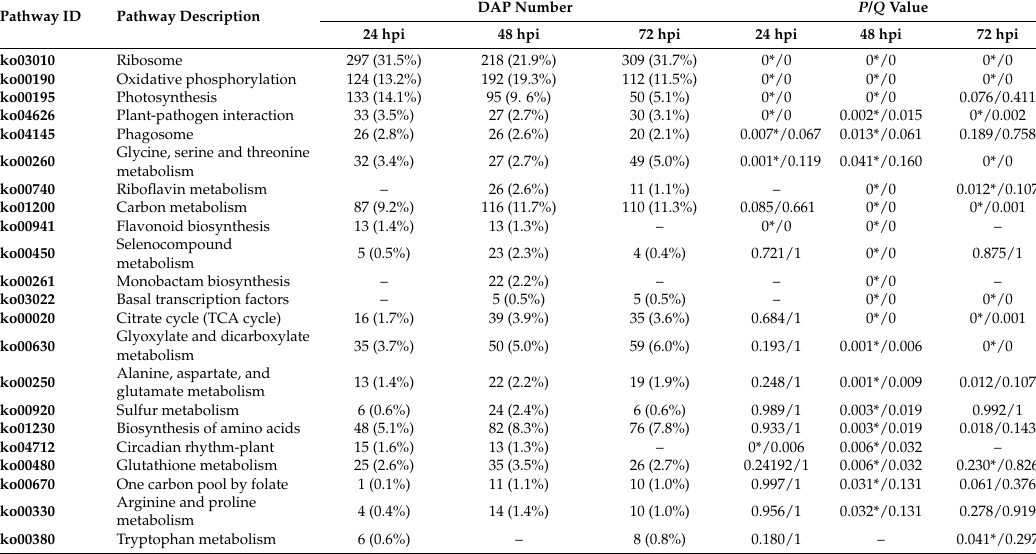
Table 1. Kyoto Encyclopedia of Genes and Genomes (KEGG) pathway enrichment analysis of differentially accumulated proteins in stripe rust infection of wheat variety